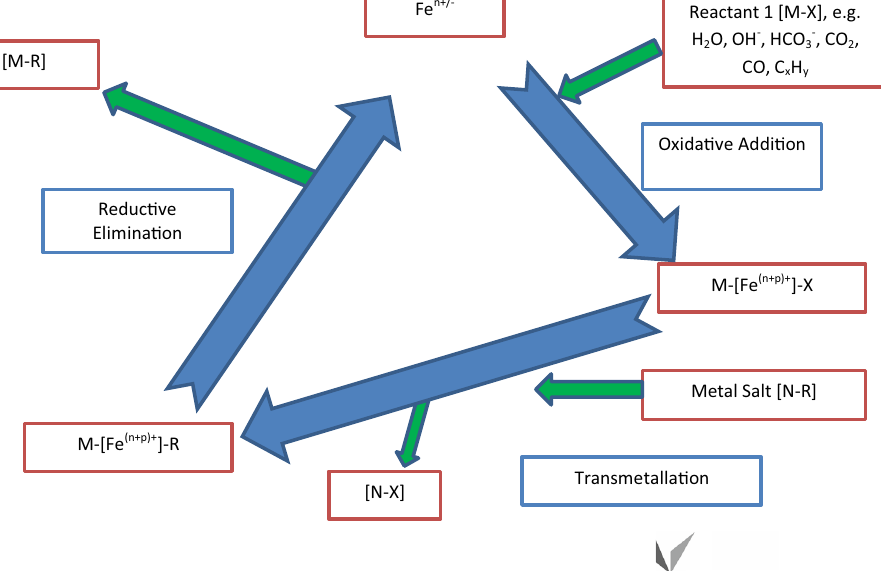
Fig. 1 Schematic flowsheet for each desalination catalytic cycle. The cations M and N can vary on each cycle. The anions R and X can vary on each cycle. A similar cross-coupled cata- lytic cycle has been proposed for water treatment using ZVI (Antia